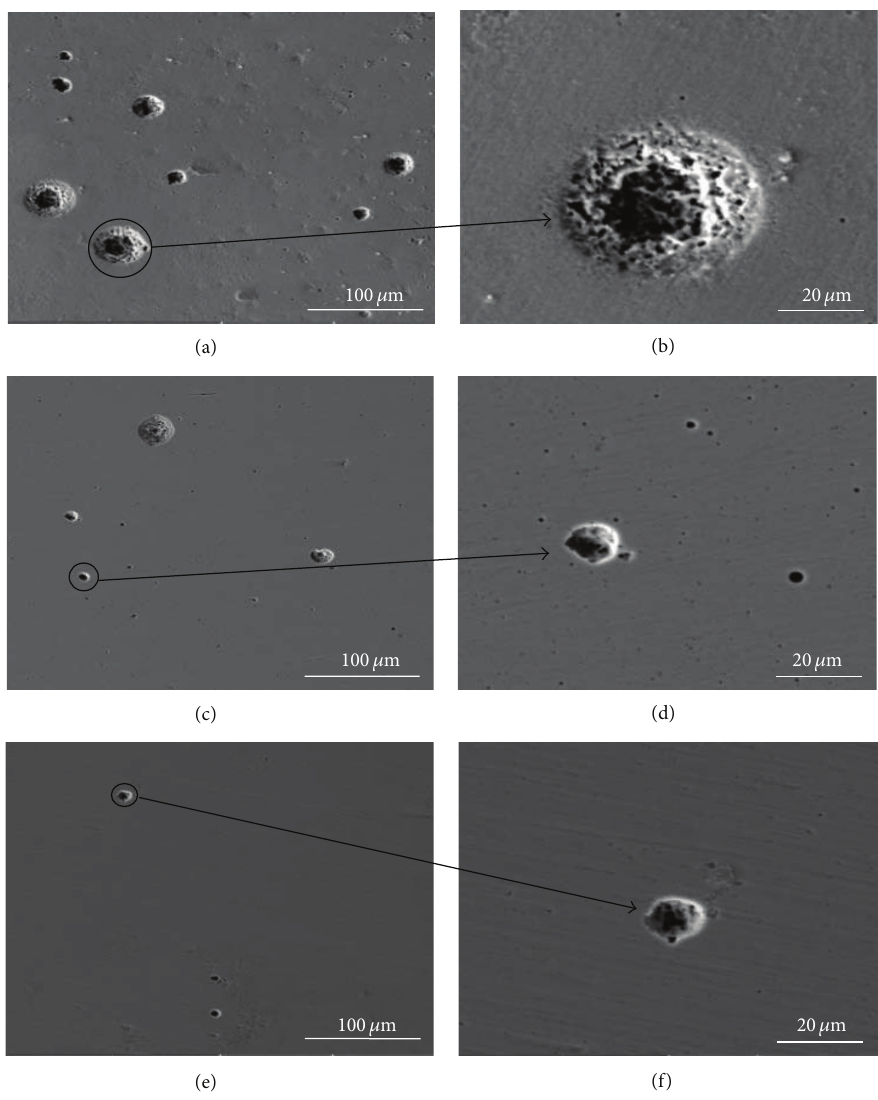
Figure 13: SEM images of corrosion morphology of passive films for X70, X80, and X100 pipeline steels after the electrochemical noise measurement for 1h in 3.5 wt.% NaCl solution (a) and (b) X70 steel; (c) and (d) X80 steel; (e) and (f) X100